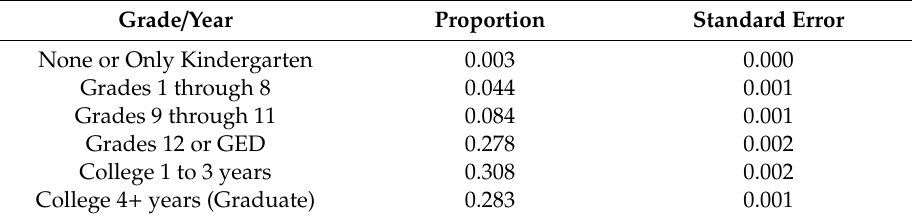
Table 2. Variable EDUCA: “What is the highest grade or year of school you completed? [20]”.